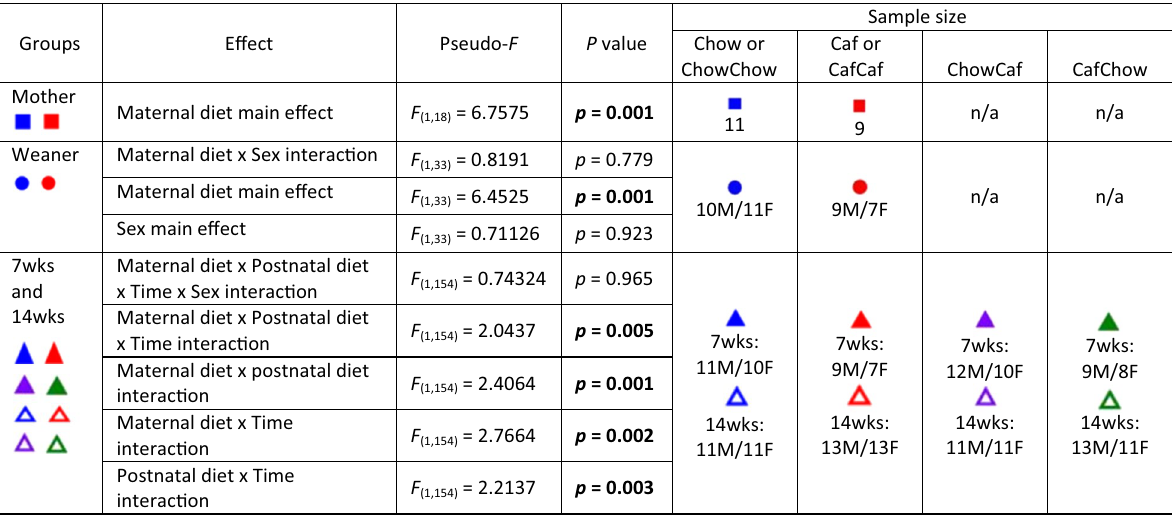
Table 2 Summary of PERMANOVA analyses